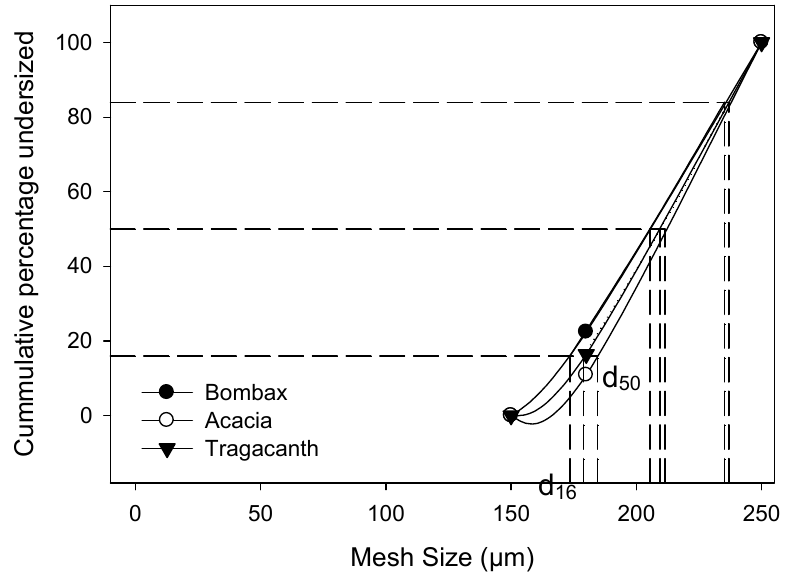
Figure 3. Particle size distribution of granules prepared from different